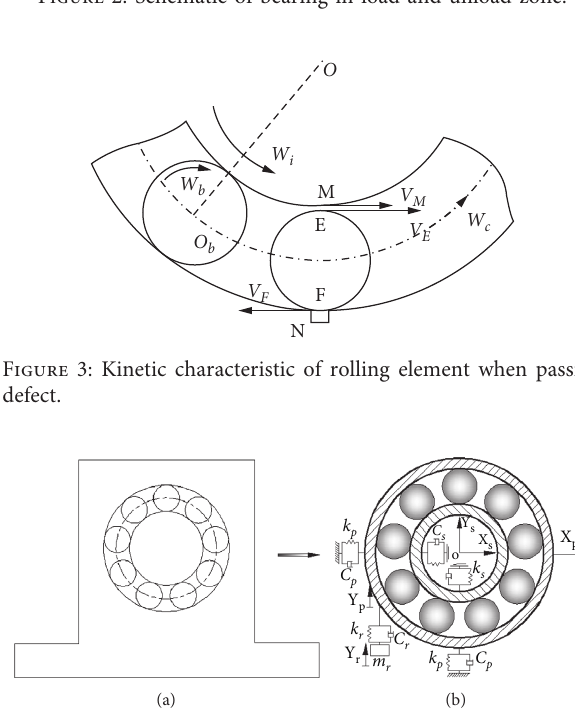
Figure 4: A 5-DOF simplified model of bearing-housing system. (a) The bearing-housing system; (b) the simplified model.